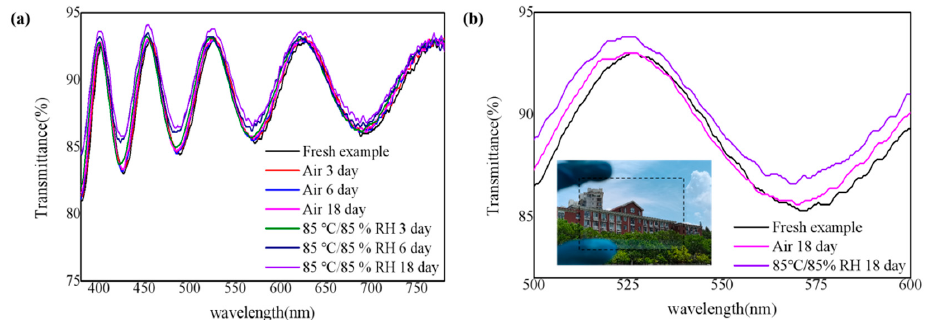
Figure 6. ( a ) The transmittance of SiN x films in the 380–780 waveband and ( b ) transmittance of part SiN x films in the 500–600 waveband, inset is the photo of SiN x film on glass with film thickness of 851 nm.